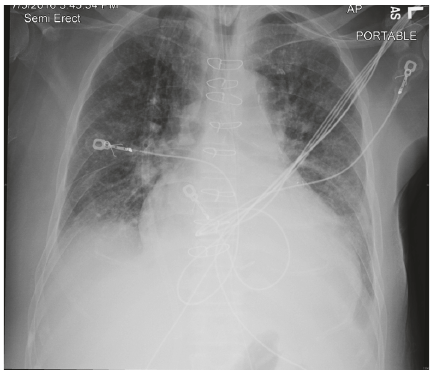
Figure 4: Portable chest radiograph following right-sided thoracen- tesis showing significant reduction in pleural